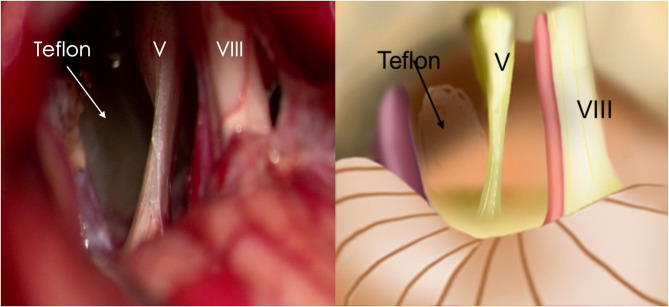
Trigeminal atrophy was observed during MVD. (V, trigeminal nerve; VIII, vestibulocochlear nerve).